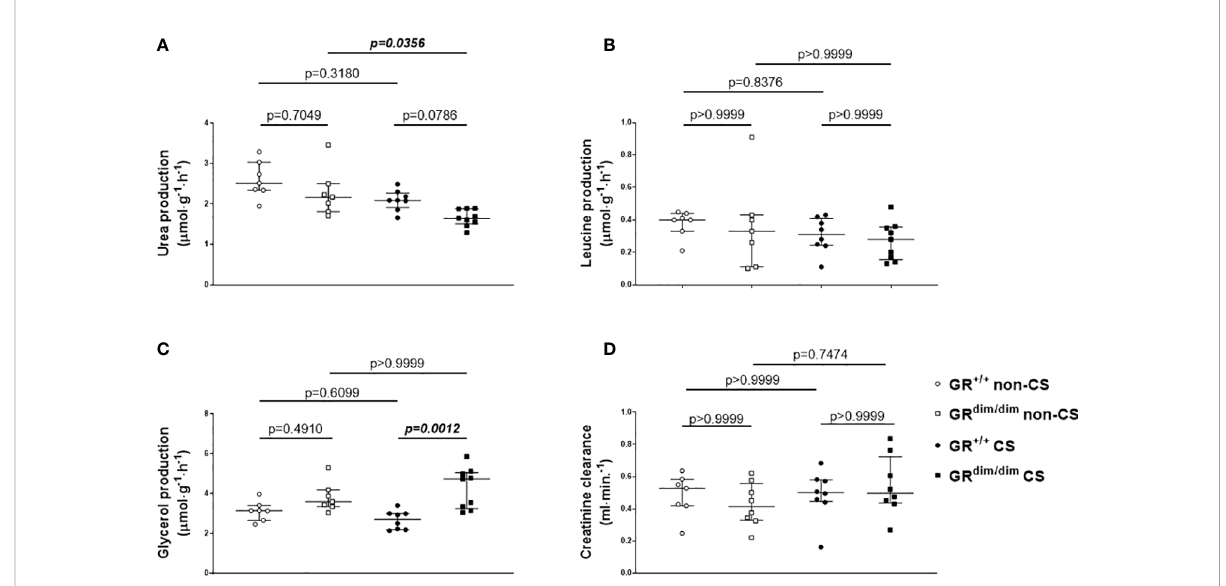
FIGURE 4 Parameters of metabolic and kidney function. Rates of appearance of (A) urea, (B) leucine, (C) glycerol as well as (D) creatinine clearance, as measures for hepatic metabolic capacity, protein degradation, lipolysis, and kidney function, respectively. *P < 0.05. # P < 0.01. GR +/+ mice non-CS: n = 7, GR dim/dim mice non-CS: n = 7-8, GR +/+ mice CS: n=8, GR dim/dim mice CS: n = 8-9. Data is presented as median (25 th and 75 th percentile and